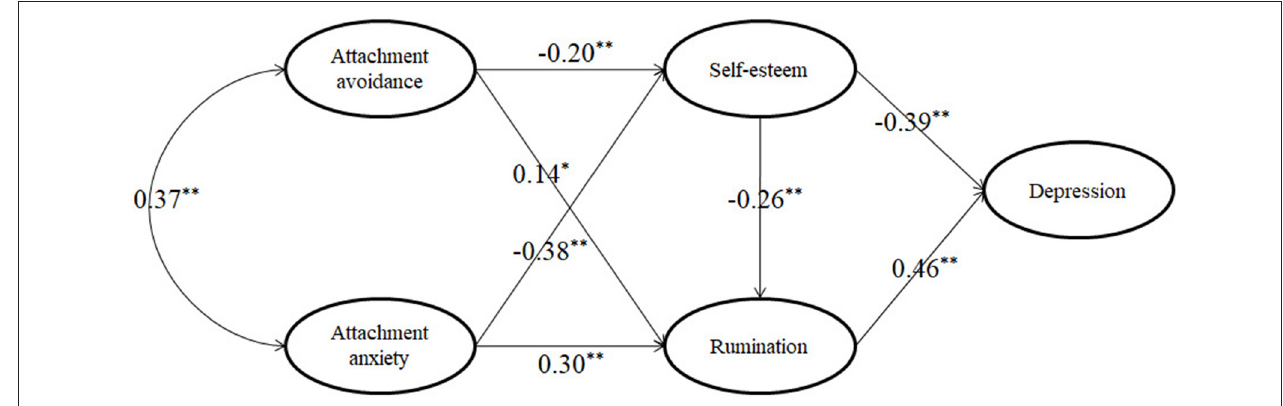
FIGURE 3 | Structural model. * P < 0.05; ** P < 0.01.